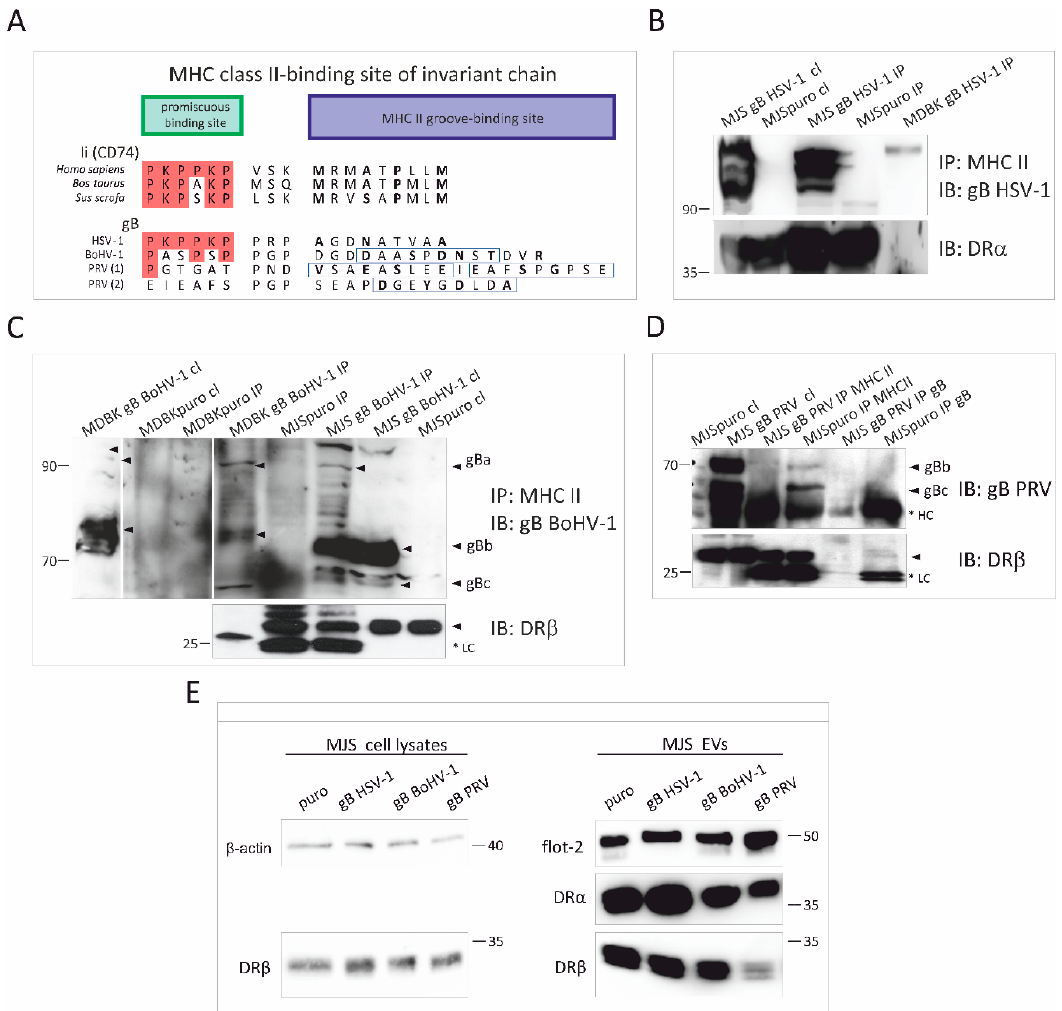
Figure 5. Analysis of interaction between MHC II and HSV-1, BoHV-1 or PRV gB, and the e ff ect of alphaherpesvirus gB on MHC II incorporation in EVs. ( A ) Comparison of amino acid sequences representing potential HSV-1, BoHV-1, and PRV gB and MHC II biding site. HSV-1 gB contains an allotypic HLA-DR-binding region homologous to the human invariant chain (Ii, CD74), consisting of the promiscuous and the MHC II groove-binding sites. Whereas bovine and porcine Ii sequences are highly conserved, their corresponding regions in BoHV-1 and PRV gB (two candidate sequences) are variable. Amino acids (aa) that are identical to those in human Ii are in red frames. Boxes highlight predicted MHC II peptides. The groove-binding positions are in bold. ( B ) Complex formation between HSV-1 gB and HLA-DR or bovine MHC II from cell lysates was evaluated by co-immunoprecipitation (IP) using anti-MHC II mAb. Immunoprecipitated proteins were separated by SDS-PAGE and detected by immunoblotting (IB) with anti-gB or anti-DR α antibodies (for human cells). ( C ) and ( D ) Co-IP with anti HLA-DR or bovine MHC II (in C) mAb from MJS BoHV-1 / PRV gB or MDBK BoHV-1 gB lysates. gB or DR β were detected in SDS-PAGE-separated complexes by IB. Size markers are in kilodaltons. *LC: light chain of antibodies; HC: heavy chain of antibodies. Arrows indicate gB species. ( E ) Detection of DR α , DR β and flotillin-2 (flot-2) as an EVs marker in SEC-purified EVs by IB. β -actin and DR β were detected in cell lysates for comparison. Size markers are in kilodaltons.